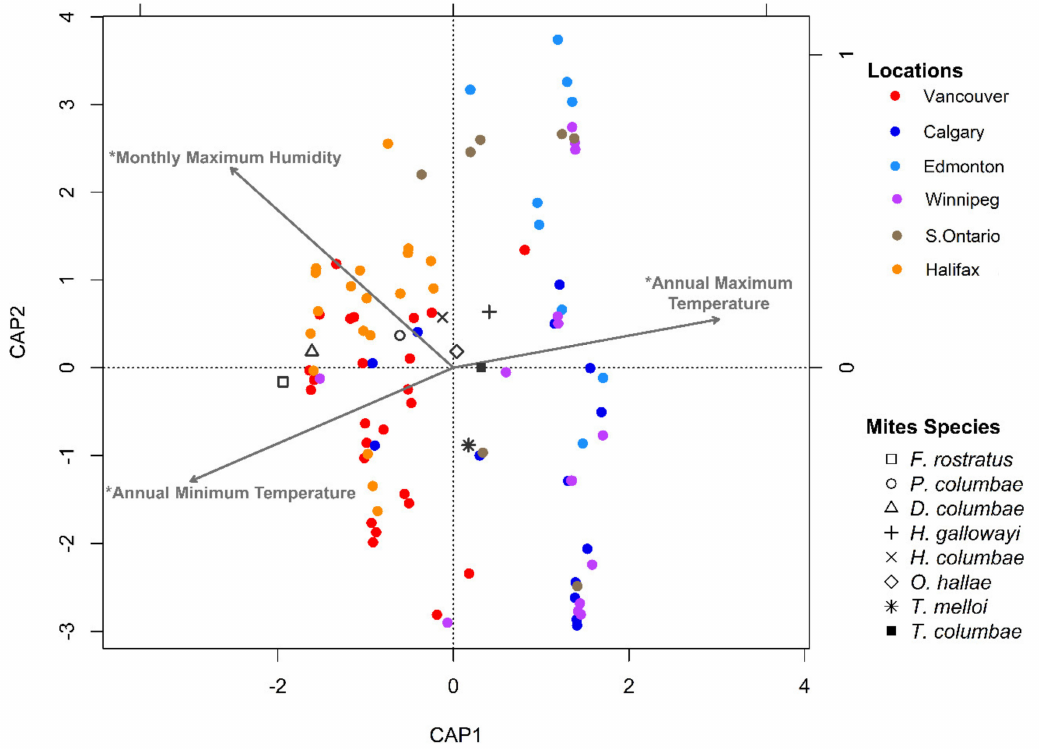
Figure 8. Distance-based redundancy analysis plot of mite assemblages (presence-absence data) from Columba livia sampled from six locations across Canada. Vectors are meteorological variables chosen through forward selection. An asterisk (*) indicates a p -value < 0.05 after correction for multiple